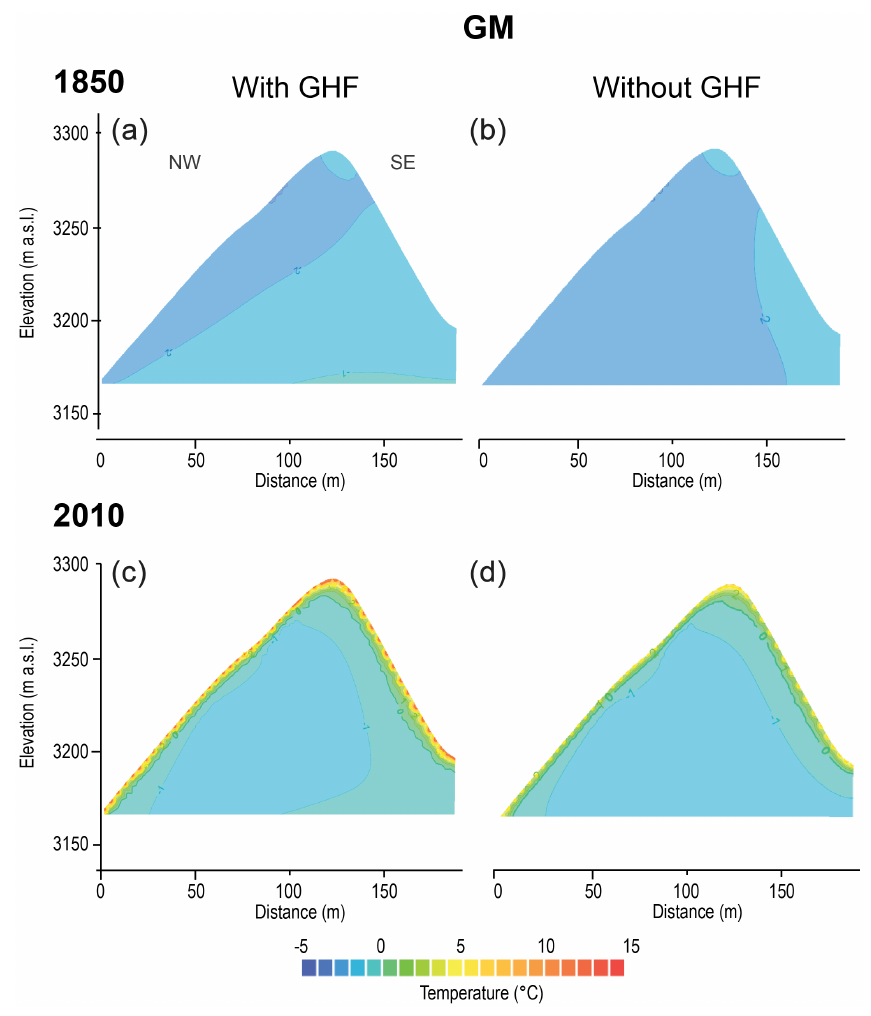
Figure 9. Bidimensional thermal fields at the GM site for steady-state conditions (1850) and transient conditions (2010). Models in the left panels (a, c) are run at daily time step with a geothermal heat flux (GHF) of 85mWm − 2 and a thermal conductivity of 3Wm − 1 K − 1 , whereas those on the right panels (b, d) are run at monthly time step without geothermal heat flux and with a thermal conductivity of 2.7Wm − 1 K − 1